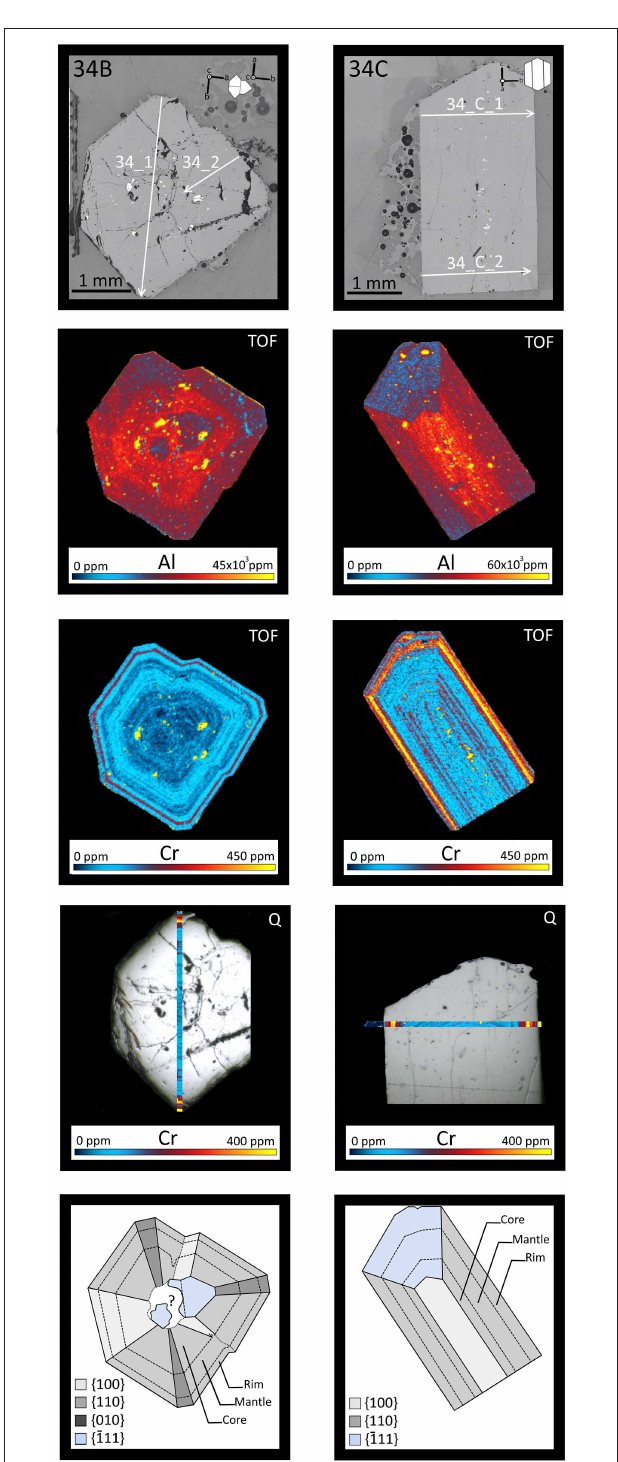
FIGURE 6 | Reflected light scans, LA-ICP-TOFMS and LA-ICP-QMS maps of crystal 34, cut along the c -axis (section 34C) and perpendicular to the c -axis (section 34B). The basal cut (34B) includes a smaller half-crystal unit oriented parallel to the main crystal but rotated 90-degrees about the c -axis. According to Cr zonation, the crystal contains a relatively homogeneous core